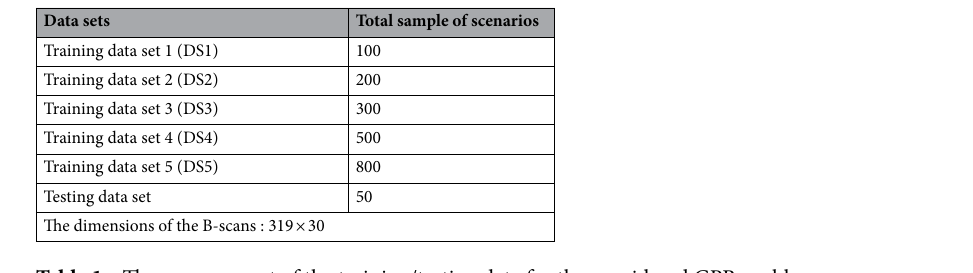
Table 1. The arrangement of the training/testing data for the considered GPR